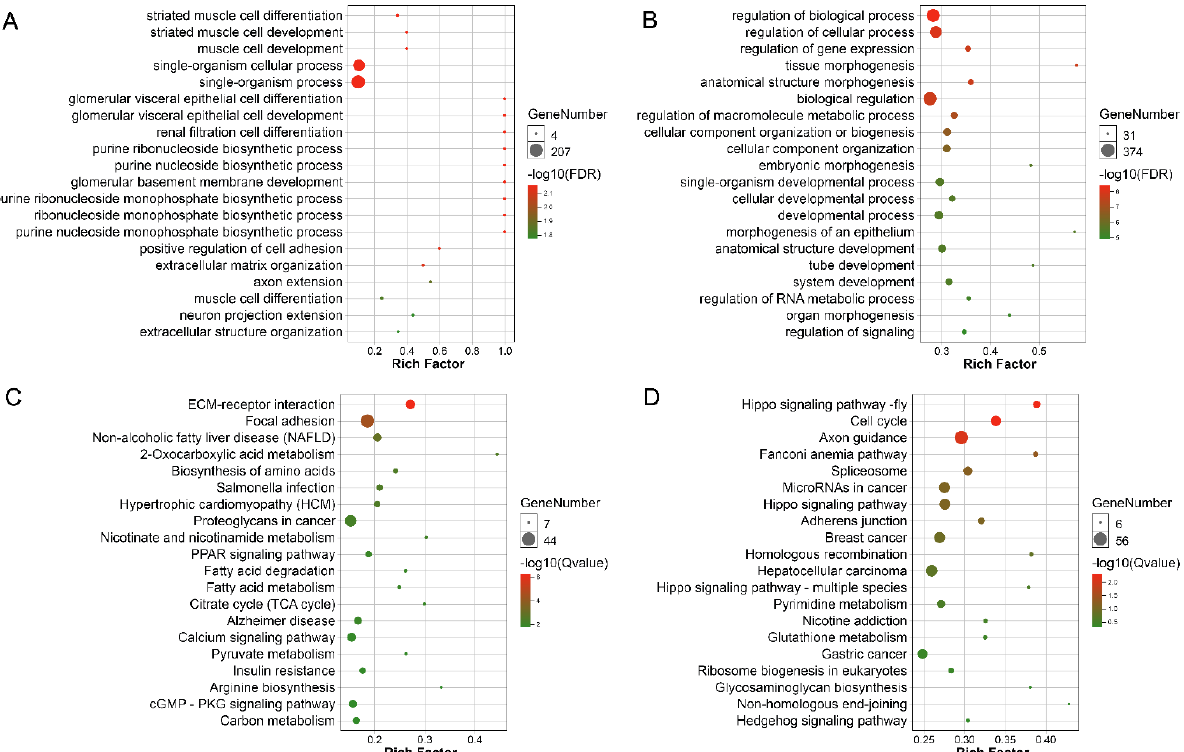
Figure 5. GO and KEGG enrichment of target genes. ( A ) The GO enrichment analysis of target genes of miRNAs in the first category of profiles. ( B ) The GO enrichment analysis of target genes of miRNAs in the second category of profiles. ( C ) The KEGG pathway enrichment analysis of target genes of miRNAs in the first category of profiles. ( D ) The KEGG pathway enrichment analysis of target genes of miRNAs in the second category of profiles.